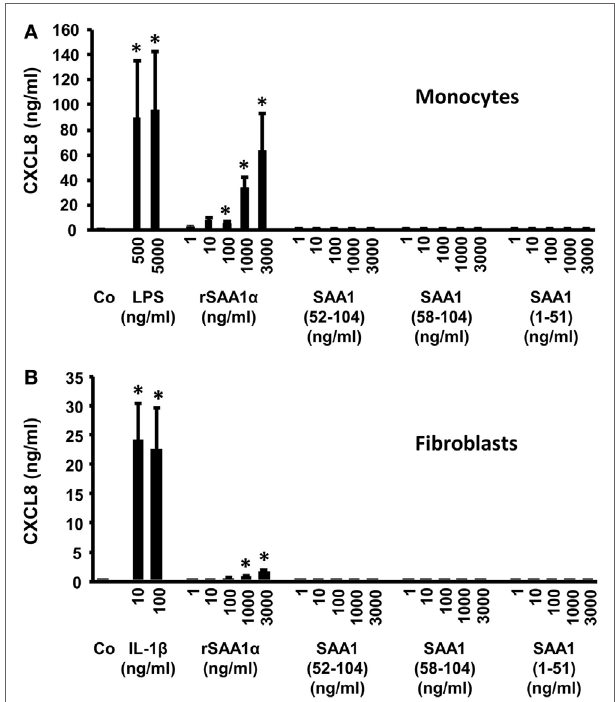
FigUre 4 | SAA1(1–51), SAA1(52–104), and SAA1(58–104) fail to induce CXCL8 in monocytes and fibroblasts. Human CD14 + monocytes (a) or diploid fibroblasts (B) were incubated with recombinant intact serum amyloid A1 (SAA1) (1–3,000 ng/ml), SAA1(1–51) (1–3,000 ng/ml), SAA1(52–104) (1–3,000 ng/ml), SAA1(58–104) (1–3,000 ng/ml), lipopolysaccharide (LPS) [500 or 5,000 ng/ml (a) ], or IL-1 β [10 or 100 ng/ml (B) ] for 24 h. Results represent the mean ± SEM CXCL8 production from four independent experiments. Asterisks indicate significant induction of CXCL8 compared with untreated (Co) samples (Mann–Whitney U test; * p < 0.05).